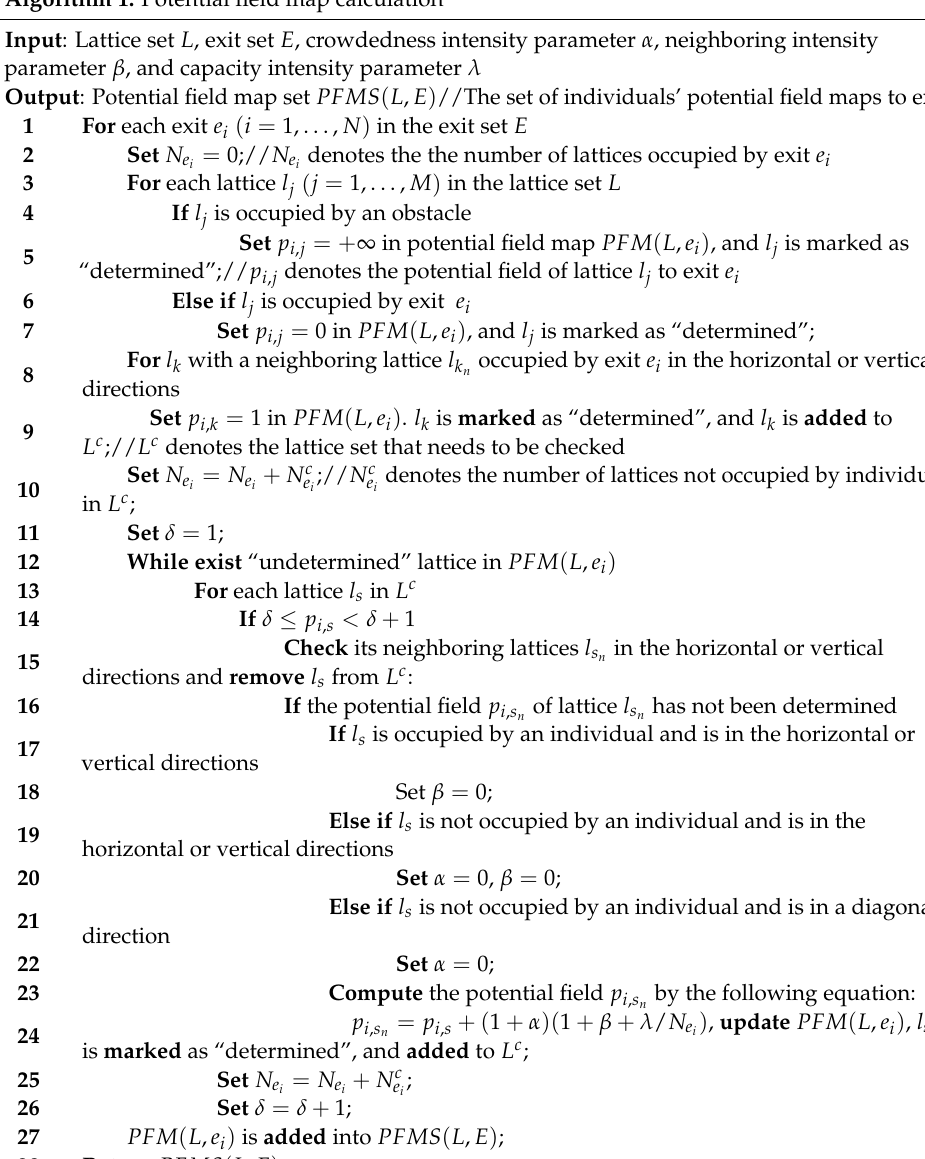
Algorithm 1: Potential field map